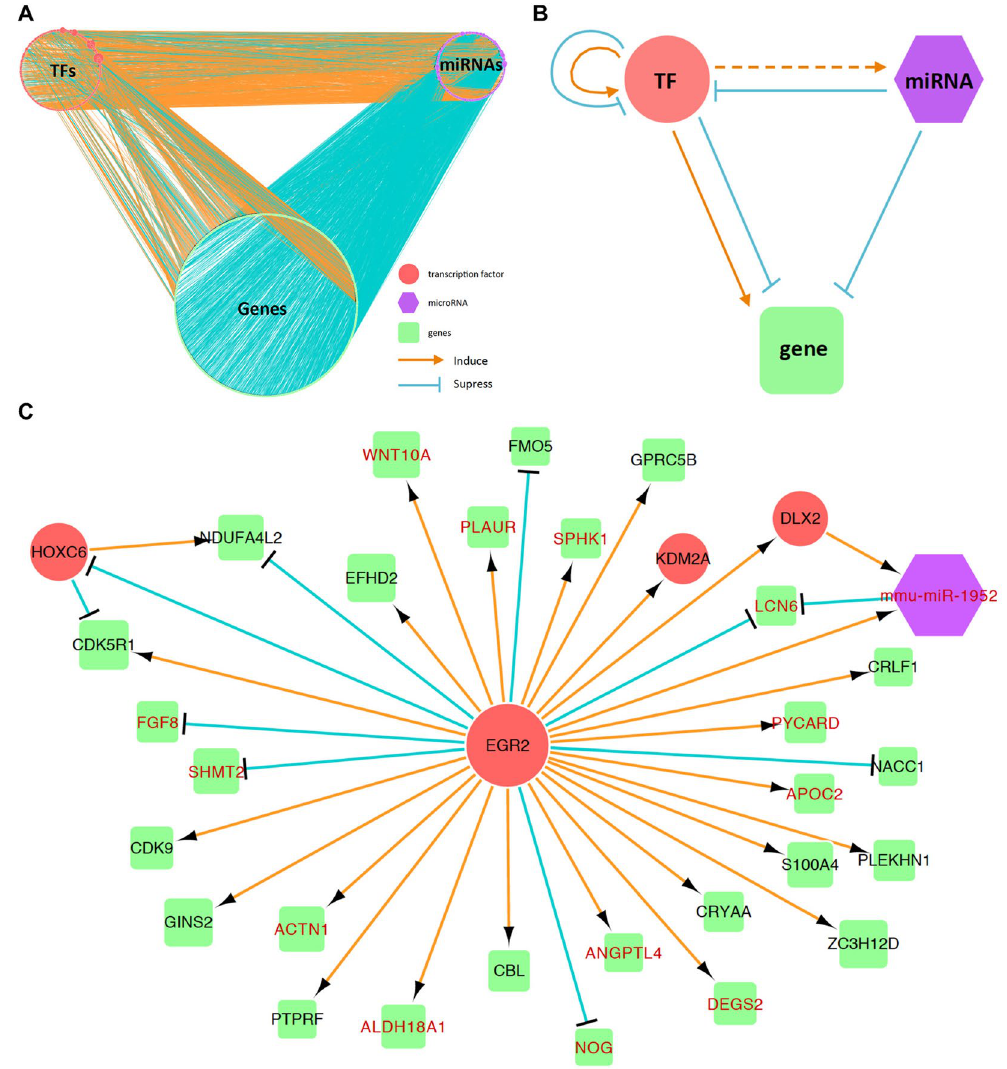
Figure 5. The gene regulatory network in TAB. ( A ) Network for all TF genes (red nodes), non-TF genes (green nodes), and miRNAs (purple nodes) and the edges of positive (orange) and negative (blue) regulations in TAB. ( B ) A schematic gene regulatory network for a TF gene, a miRNA, and a non-TF gene. ( C ) A sub-network centered at the TF Egr2 gene to its direct targets, where genes with red name represent the cardiovascular- associated (CV)